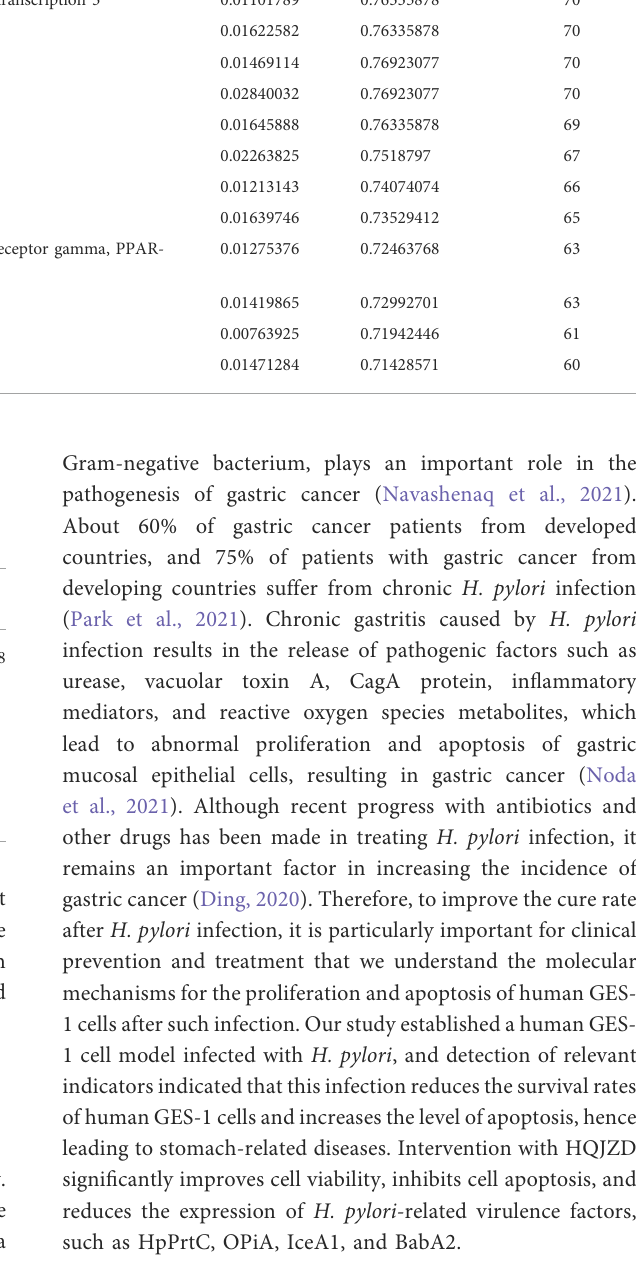
represented by lines, and the ligands are represented by different colored sticks. Results show that binding energies of 5 core proteins and 6 key components were ≤ − 5 kcal/mol, which indicates the key active components of HQJZD that can bind well to target proteins.